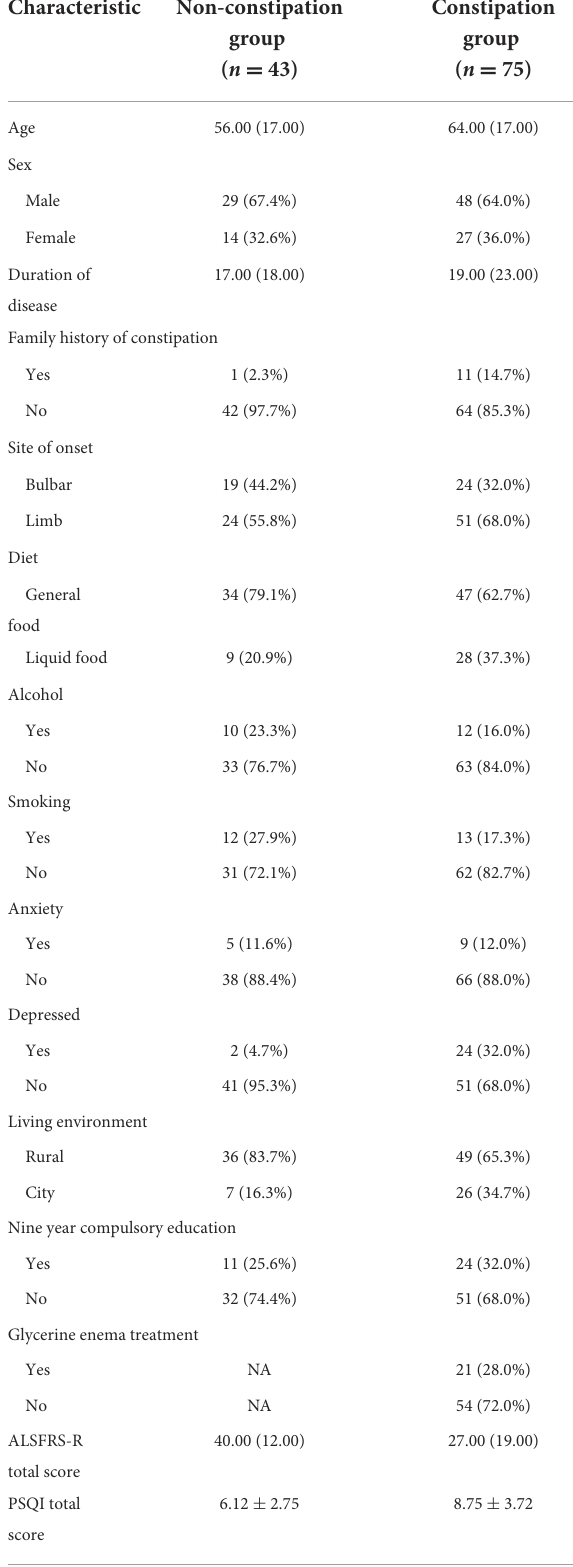
TABLE 1 Comparison of demographic characteristics and general data of ALS patients.